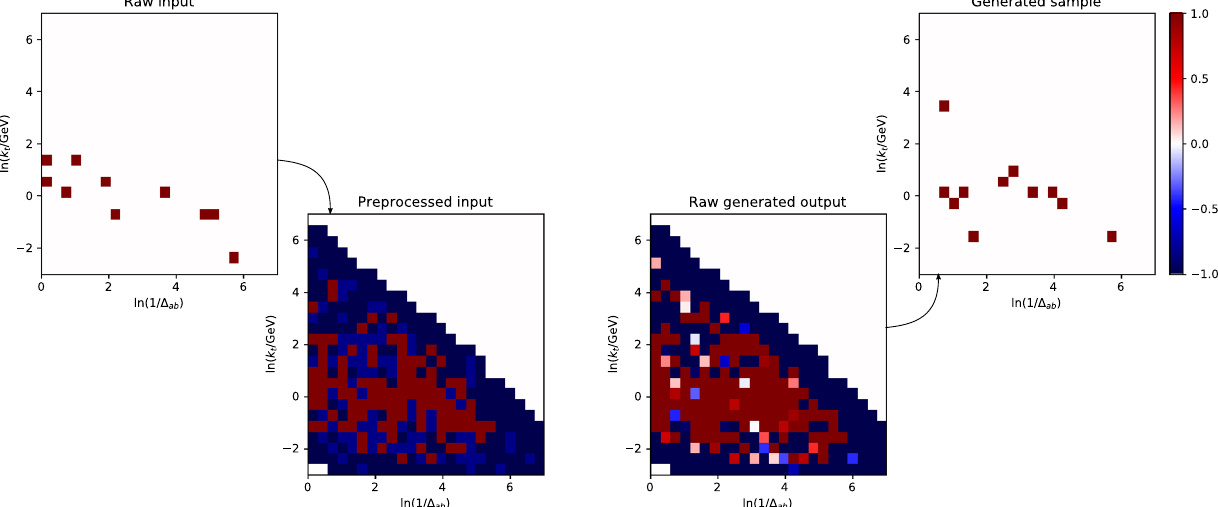
Fig. 5 Left two figures: sample input images before and after preprocessing. Right two: sample generated by the LSGAN and the corresponding Lund image